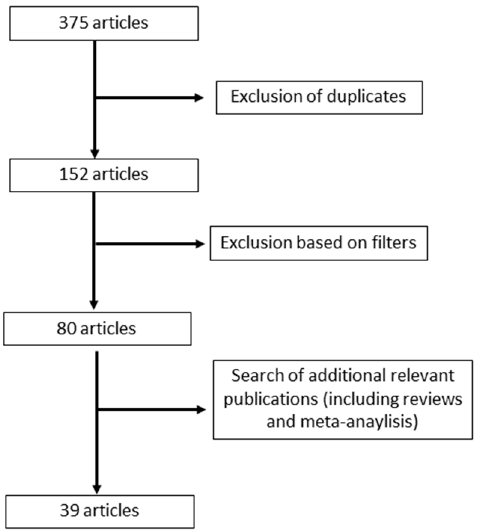
Figure 1. Flow diagram for the selection of the articles included in this review.